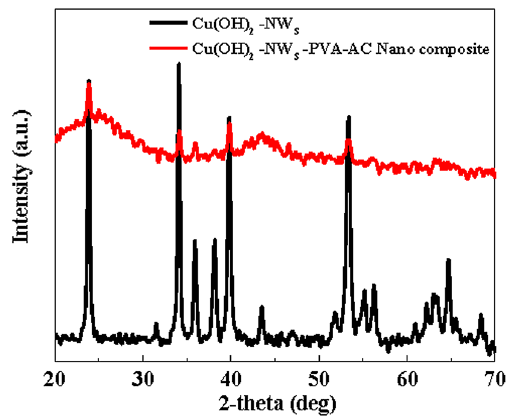
Figure 1. XRD patterns of Cu(OH) 2 -NWs, and Cu(OH) 2 -NWs-PVA-AC